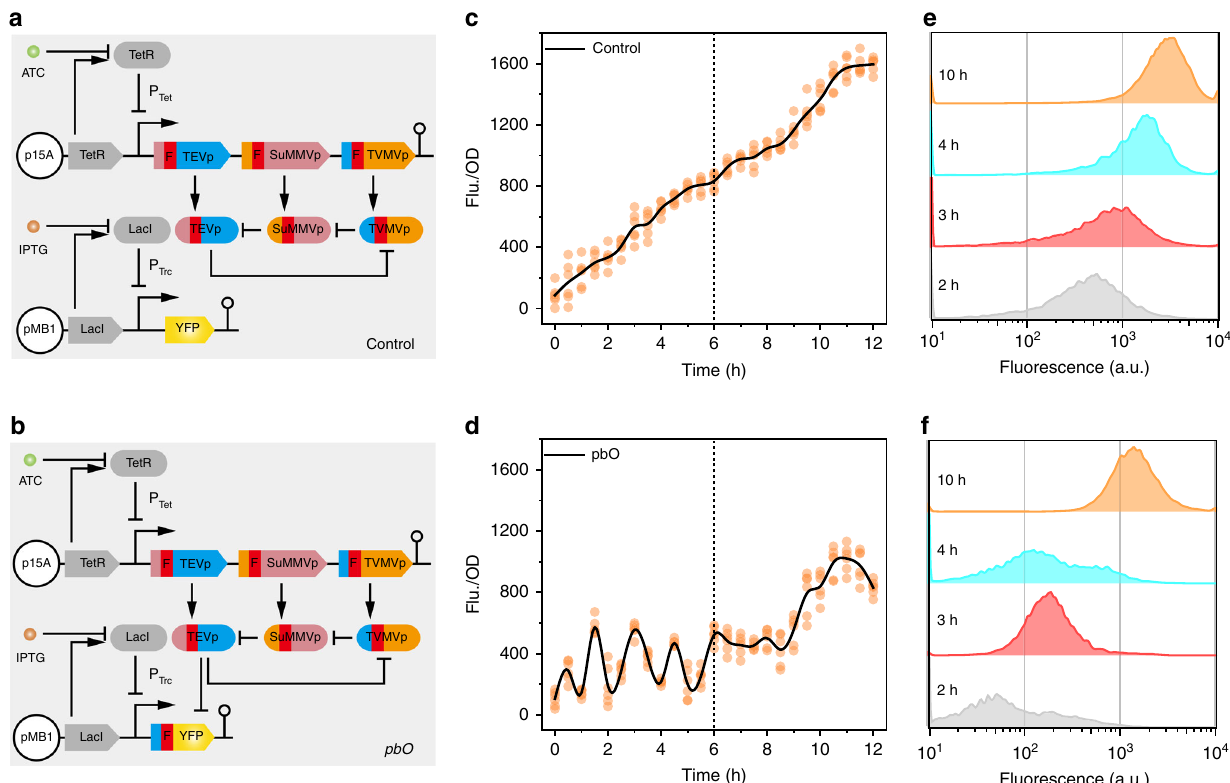
Fig. 3 The pbO design and characterization. a Control system without YFP degradation. b Three proteases trigger oscillator system. c , d Characterization of fl uorescence curve of control strain ( c ) and pbO strain ( d ). Black trace was the mean value of discrete data points measured from six separate colonies. e , f Flow cytometry measurements of control strain ( e ) and pbO strain ( f ) at different time points. Source data of Fig. 3c and 3d are provided in Source Data fi